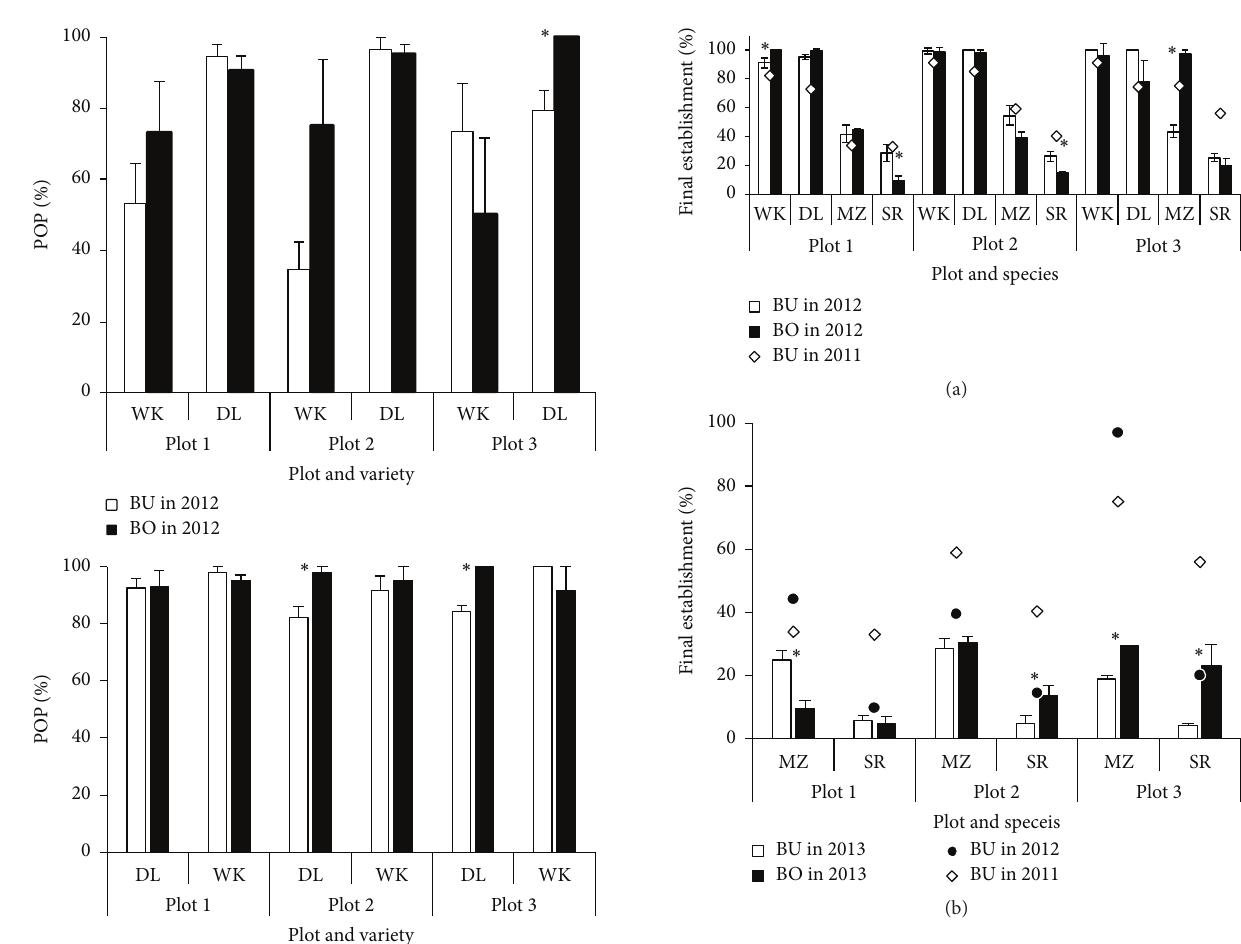
Figure 3: Final established percentage of 4 species in late autumn on December 20, 2011, and October 27, 2012 (a), and of 2 annual species on December 12, 2011, October 27, 2012, and November 15, 2013 (b) (mean ± standard deviation). ∗ shows the difference between BU and BO areas at 5% level. For both plots and species, refer to Figure